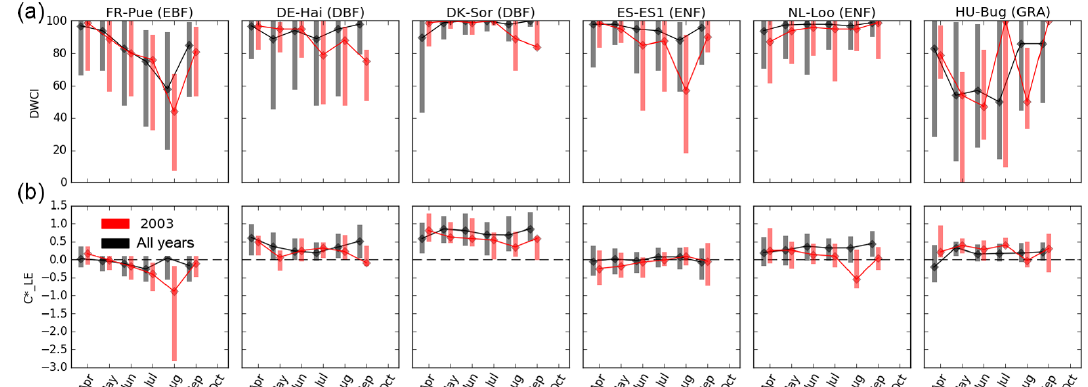
Figure 3. Monthly median Diurnal Water–Carbon Index (DWCI, lower panels) and diurnal centroids ( C ∗ Europe. Data from all years available (black) is compared to 2003 (red) during which a drought event resulted in high temperatures and low precipitation throughout the summer. Note that DWCI of 0–100 indicates lowest–highest probability of diurnal carbon–water coupling and that C ∗ of − 1 to 1 indicates 1-hour morning-shifted to 1-hour afternoon-shifted ET. Vertical bars represent interquartile range. Sites ET from four plant functional types: evergreen broadleaf (EBF), deciduous broadleaf (DBF) and evergreen needleleaf (ENF) forests, as well as grasslands (GRA). Ecosystems show tendencies of morning shifts (e.g. DK-Sor and NL-Loo) and carbon–water decoupling (e.g. ES-ES1 and HU-Bug) during the drought year.